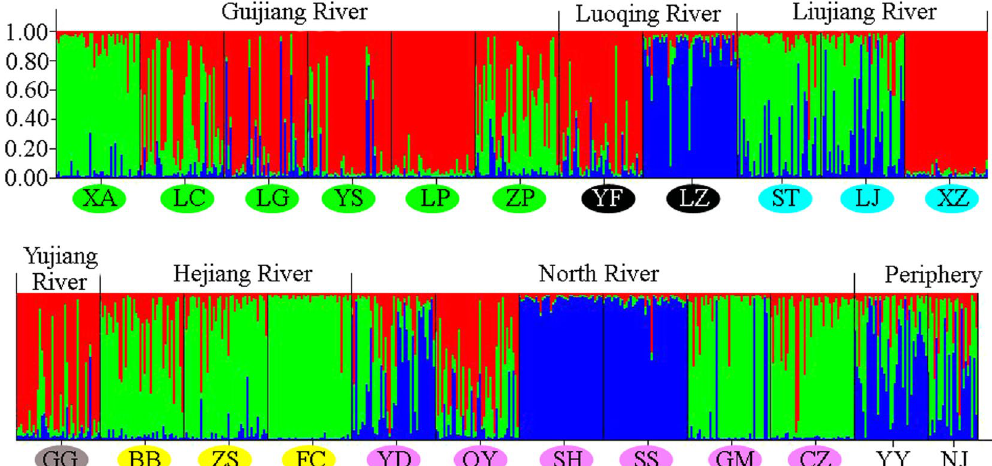
Figure 2. Bayesian results based on STRUCTURE among 23 populations of P. clarkii at K = 3; each individual was represented using a vertical bar displaying membership coefficients. Cluster 1 = red, cluster 2 = blue, cluster 3 = green. Populations with the same colour are distributed in a river. Lipu (LP), Lingui (LG), Yongfu (YF), Yangshuo (YS), Xing’an (XA), Lingchuan (LC), Shatang (ST), Luzhai (LZ), Liujiang (LJ), Xiangzhou (XZ), Guigang (GG), Babu (BB), Zhaoping (ZP), Zhongshan (ZS), Fuchuan (FC), Yingde (YD), Qingyuan (QY), Sihui